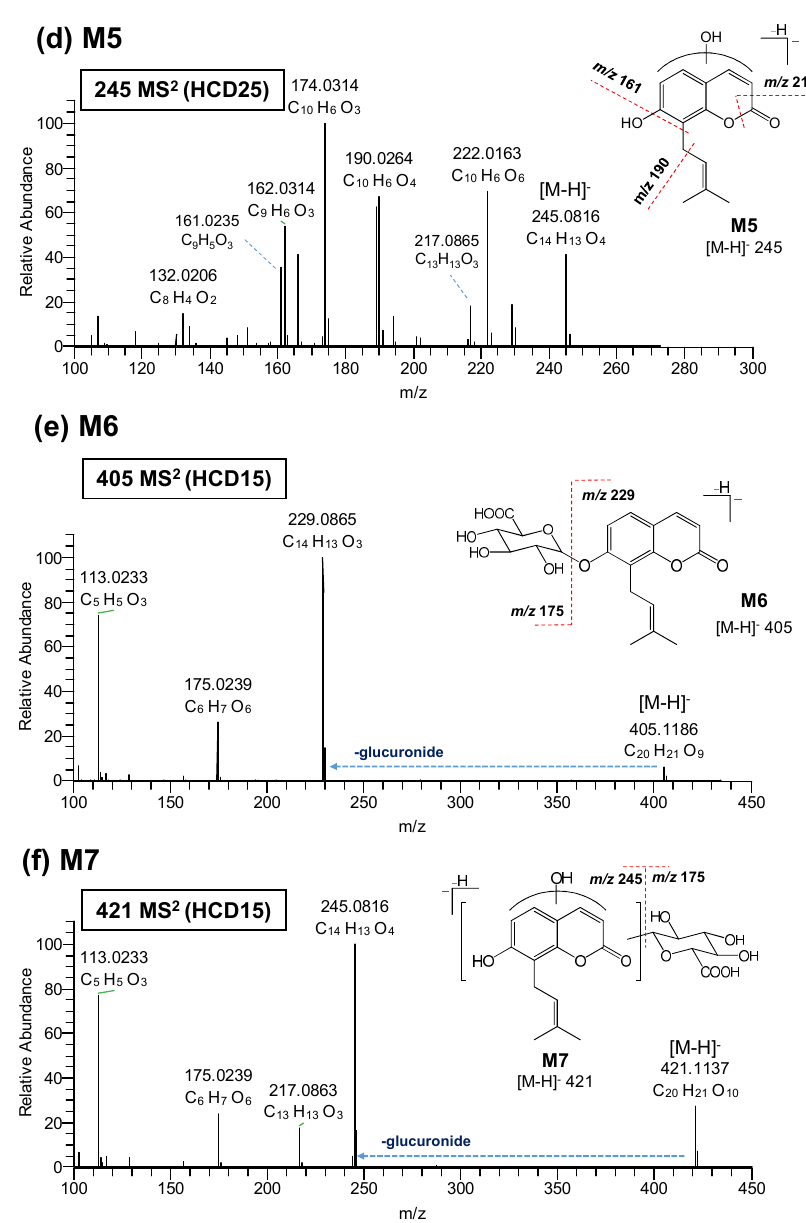
Figure 3. MS/MS spectra of protonated osthenol ( a ), 5 hydroxylated osthenol (M1–M5, ( b )–( d )), osthenol-glucuronide (M6, ( e )), and hydroxyl glucuronide osthenol (M7, ( f )) using high-resolution/high-accuracy tandem mass spectrometry.